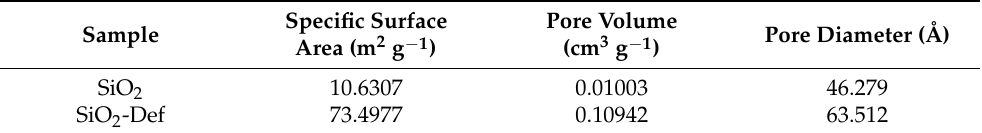
Figure 5. Nitrogen adsorption isotherms ( a ) and pore size distribution curves ( b ) of SiO 2 and SiO 2 -Def (STP means standard temperature and pressure, the arrows point to the vertical coordinates of each side). Table 2. Specific surface areas, pore volumes, and pore diameters of SiO 2 and SiO 2 -Def. Sample